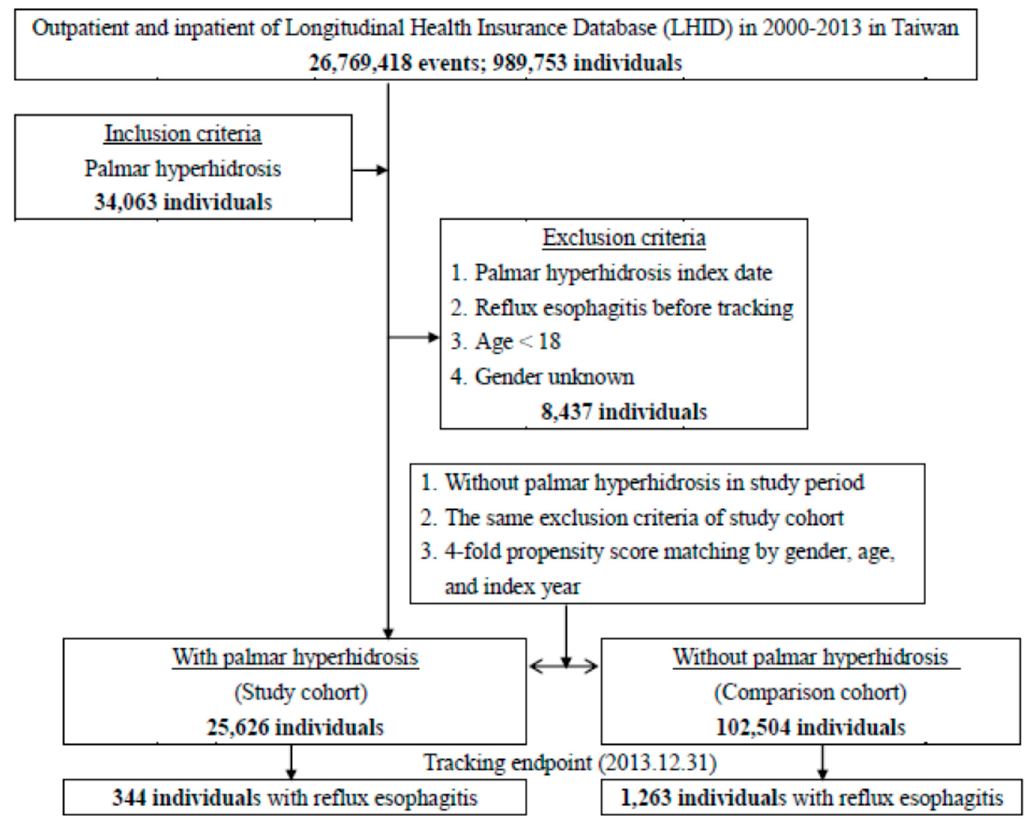
Figure 1. The flowchart of this study.